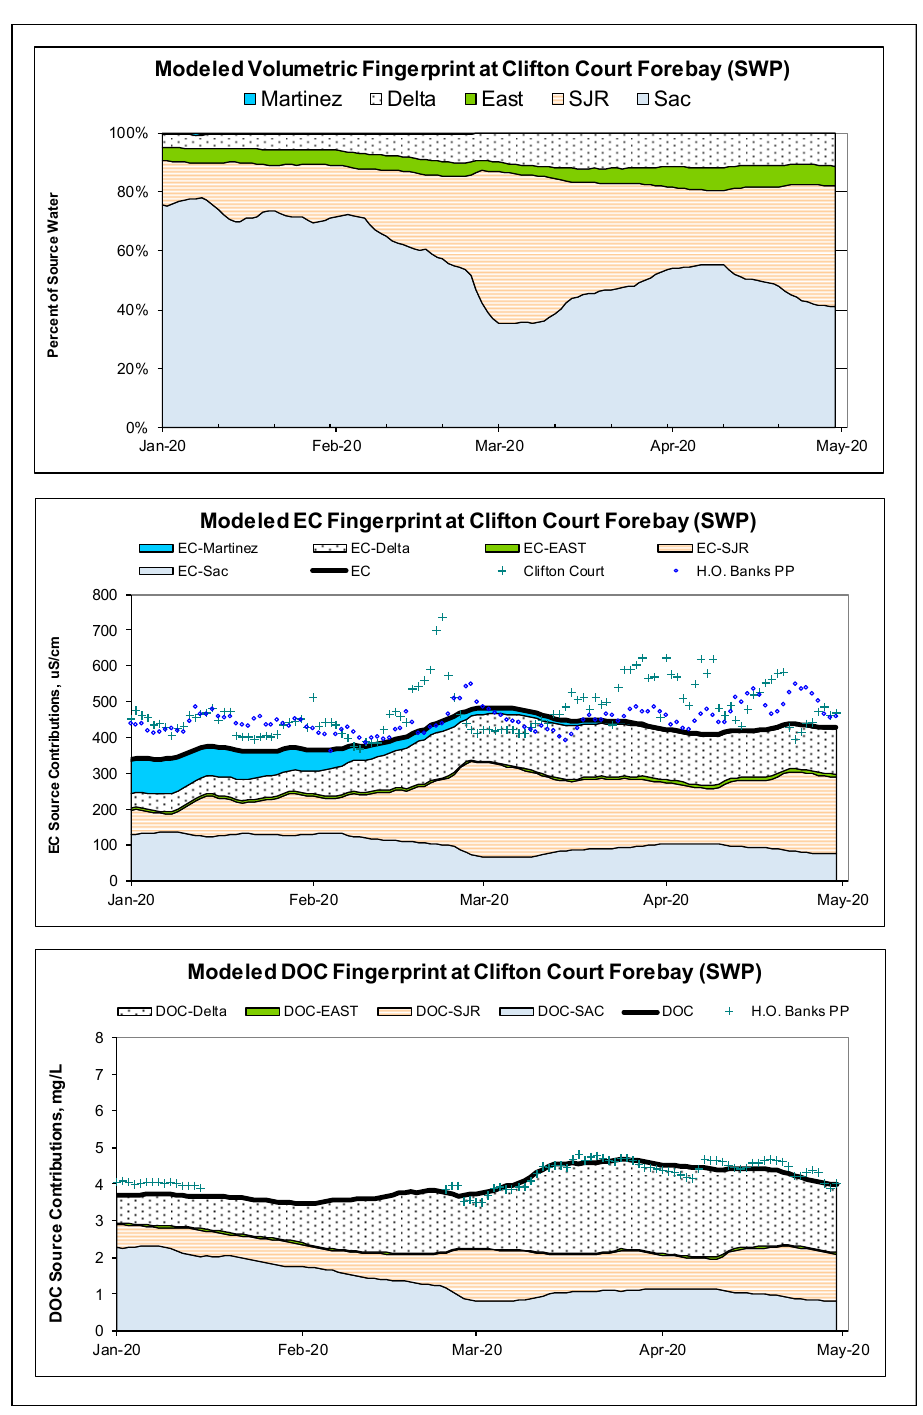
Figure 4. Representative fingerprint charts for Clifton Court Forebay using the DSM2 model. Sources tracked by the model include seawater intrusion (Martinez), in-Delta agricultural return flows (Delta), Cosumnes and Mokelumne Rivers (East), San Joaquin River at Vernalis (SJR), and Sacramento River at Hood (Sac). Symbols show the observed concentrations at these stations.